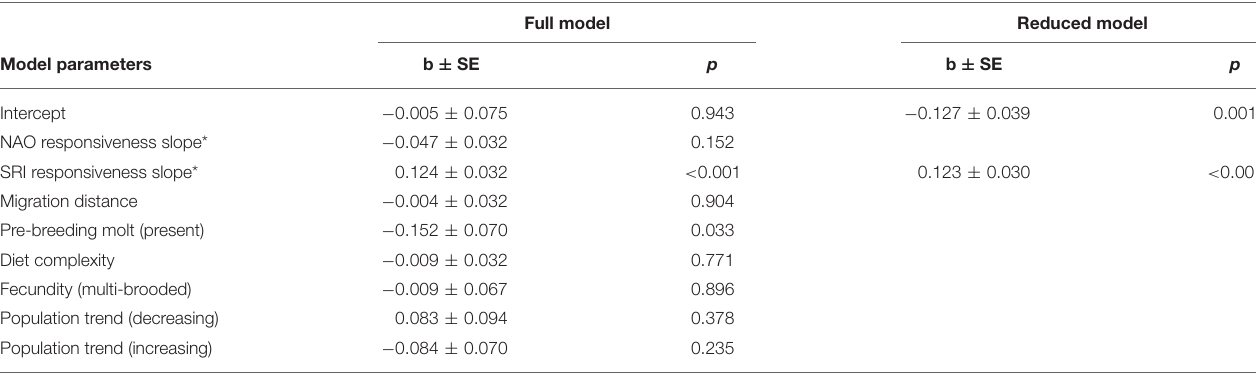
TABLE 3 | Phylogenetic generalized least squares models predicting the change in FAD over time in species that did not overwinter at the study site in more than 1 year ( N = 85 species).